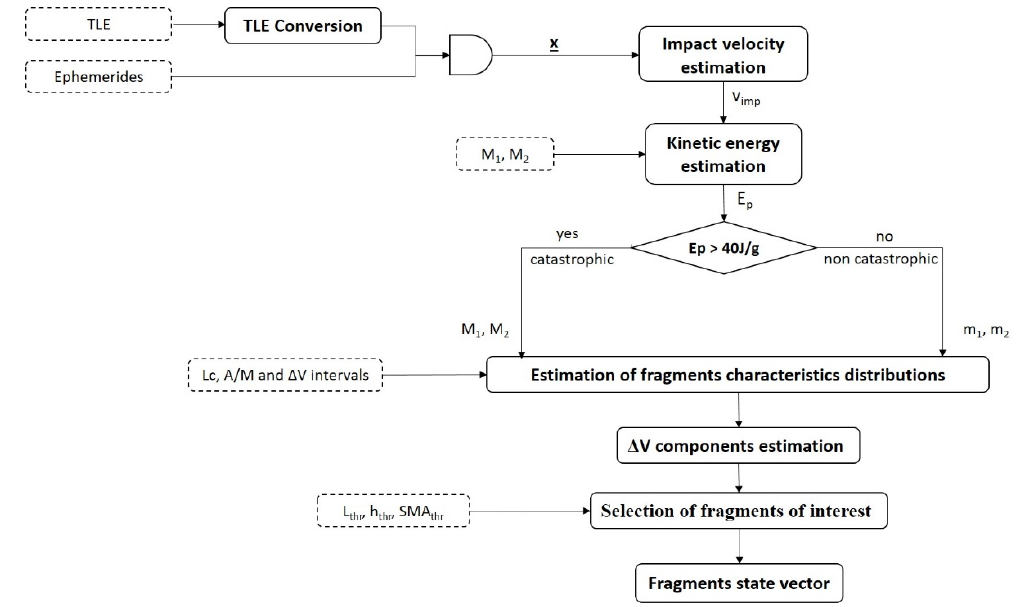
Figure 5. Scheme of SBM implementation. Each fragment is characterised by physical characteristics (i.e., size, mass, A/M ) and a state vector (i.e., position and velocity).